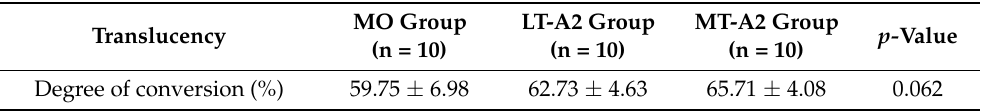
Table 3. Mean values ( ± SD) for the degree of conversion (DC) depending on the ceramic’s translu- cency. All the veneers have a 1 mm thickness.